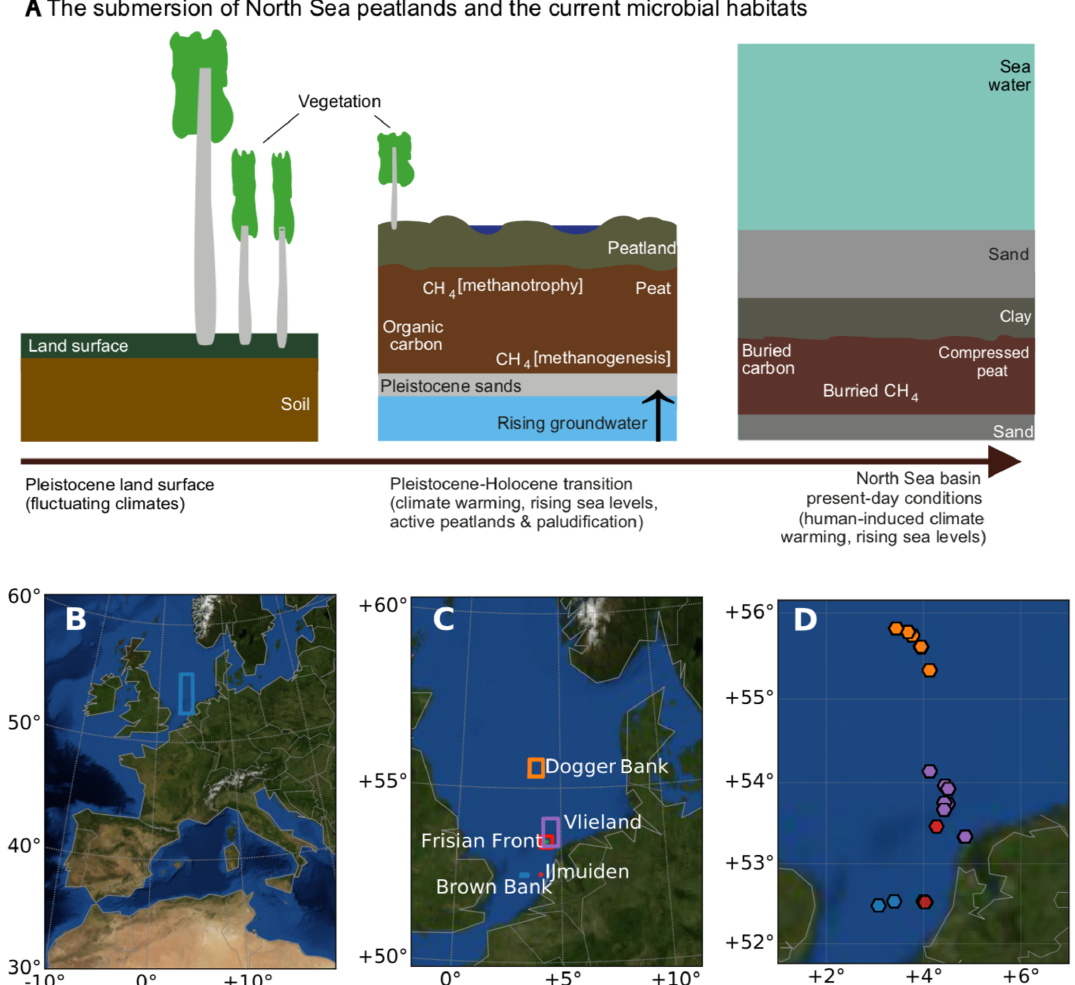
Figure 1. Peats submerged beneath the North Sea region of study. (a) Schematic of the evolution of processes that led to the conversion from the Pleistocene land surface to the buried marine peat sediments as they occur today. (b) The location of the sampling area within the context of western Europe. (c) The sampling areas and (d) the sampling sites in the North Sea, coloured according to the area names, plotted in panel (c) . Panels (b) , (c) , and (d) were generated using Python’s Basemap module, and the background map image uses NASA’s Earth Observatory’s Blue Marble: Next